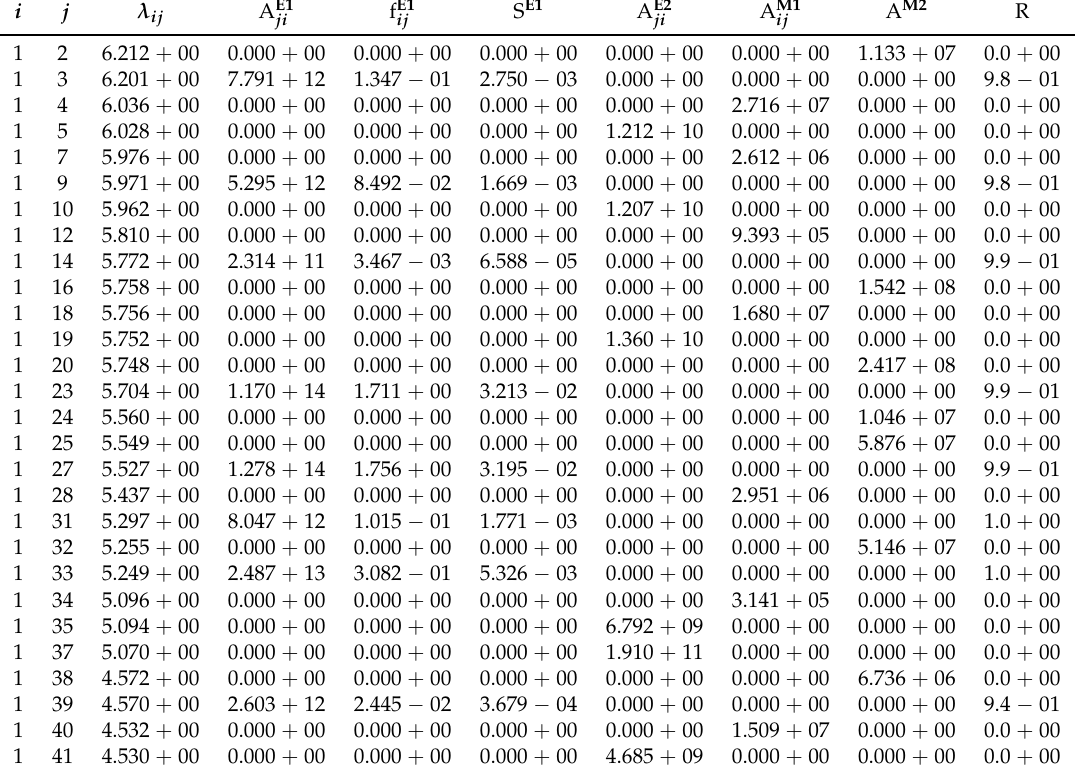
Transition wavelengths ( λ ij in Å), radiative rates (A ji in s − 1 ), oscillator strengths (f ij , dimensionless), and line strengths (S, in atomic units) for electric dipole (E1), and A ji for E2, M1 and M2 transitions in Y XXX. The last column gives the ratio R of the velocity and length forms of A(E1). a ± b ≡ a × 10 ± b